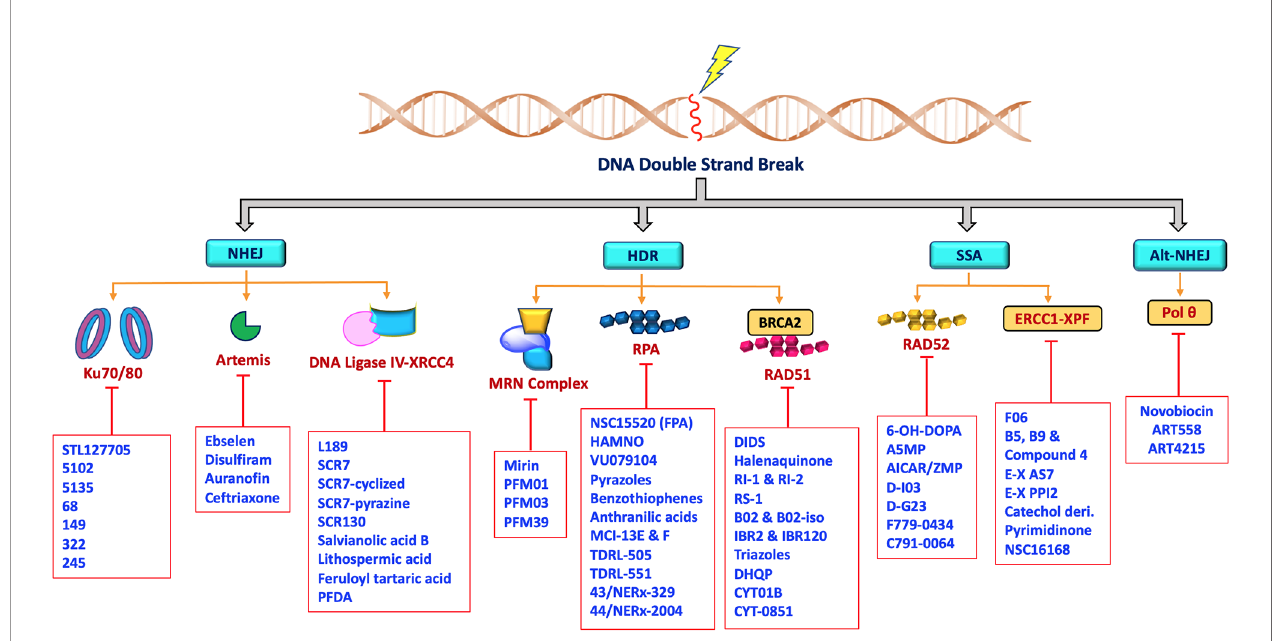
FIGURE 2 | Schematic representation showing non-PIKKs DSB repair inhibitors that target key/core and accessory proteins involved in DSB repair